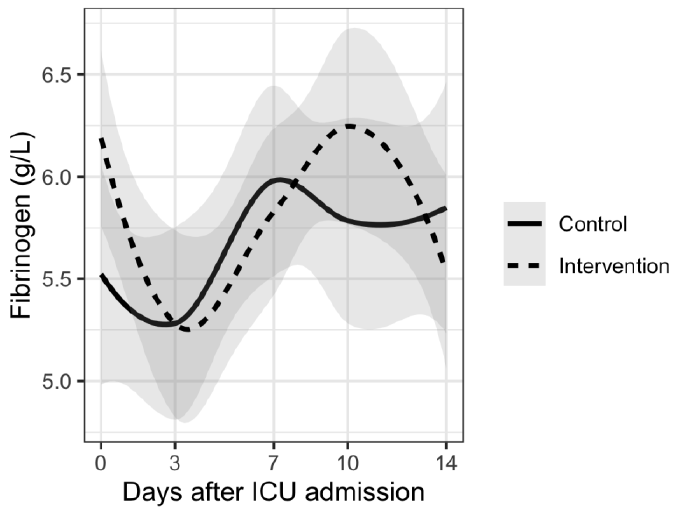
Figure 4. Mean fibrinogen levels and trends during 14 days from ICU admission.